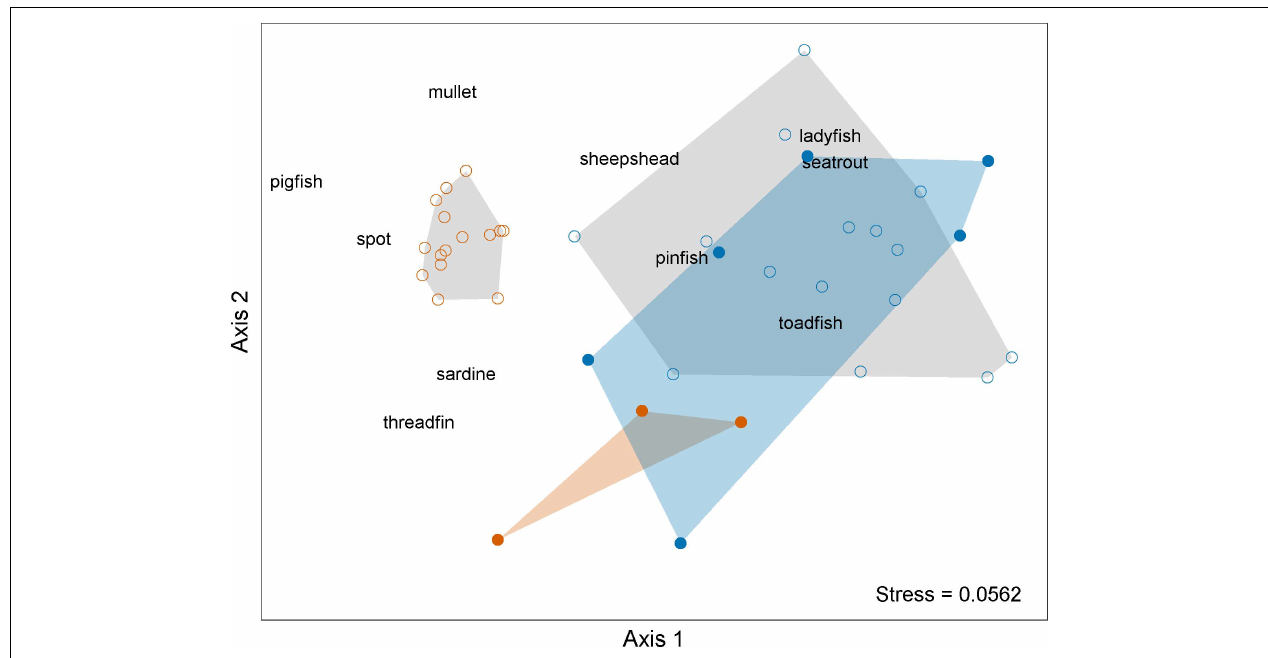
FIGURE 9 | Non-metric multidimensional scaling (NMDS) ordination of prey assemblage structure based on year, season, and bloom condition during red tide events during 2004–2019 in Sarasota Bay, Florida. Symbols: • = summer red tide conditions, orange convex